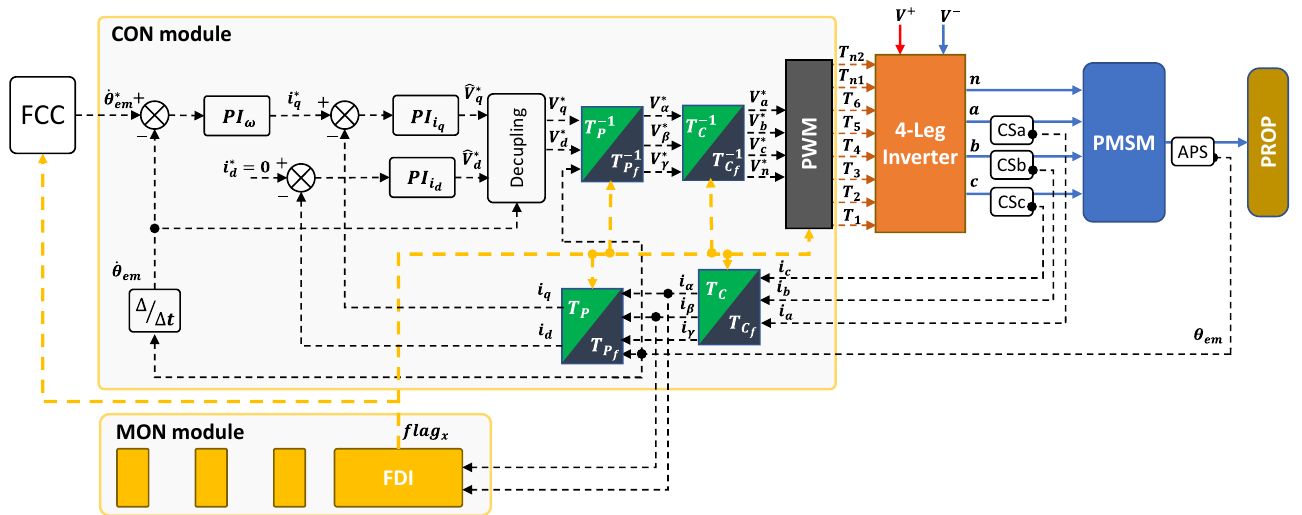
Figure 9. PMSM closed-loop system with FTC strategy.